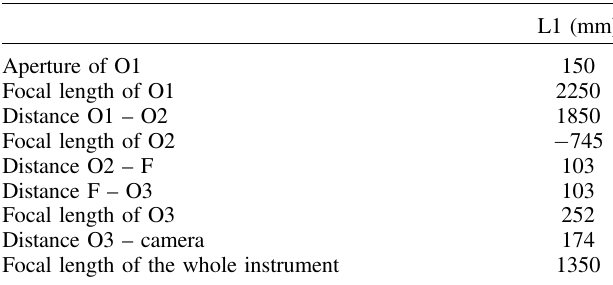
Table 2. Optical speci fi cations of